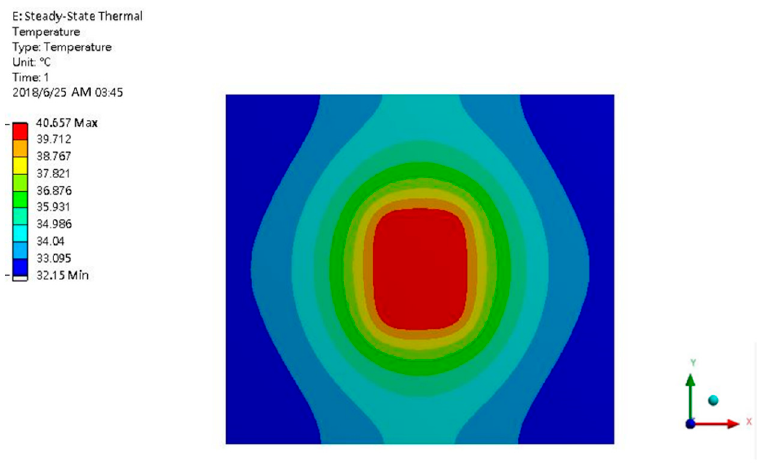
Figure 11. Temperature field distribution of thermal conductivity of 1600 W/mK.